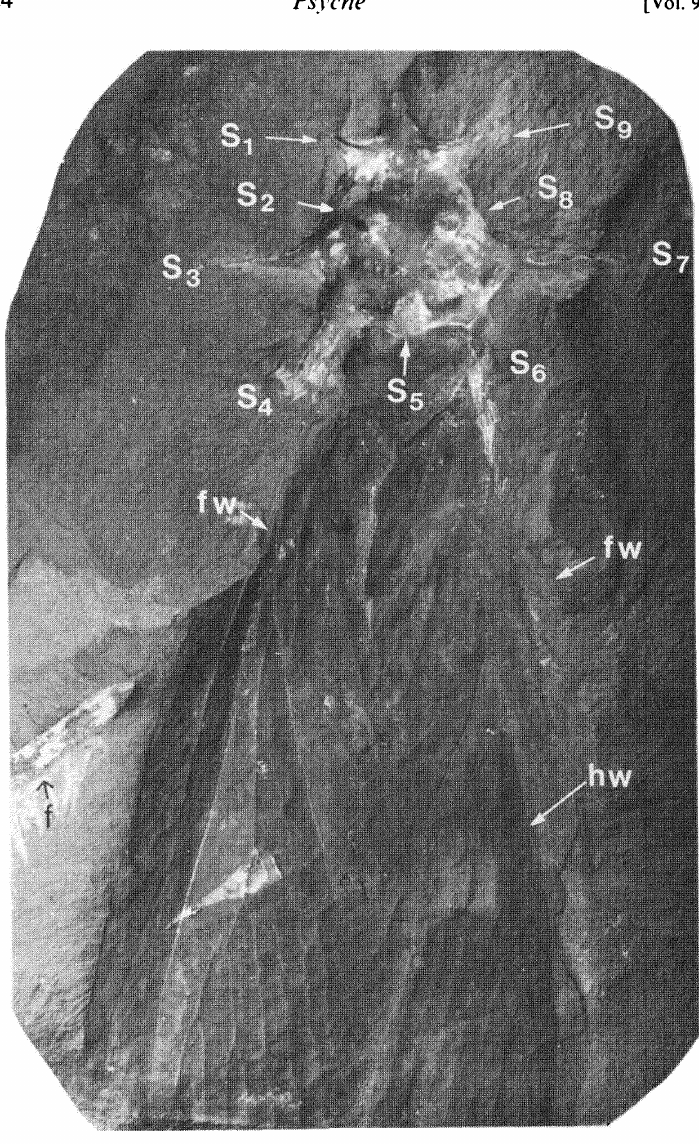
Fig. 10. Gerarus danielsi, photograph of FMNH PE 5276, obverse half. Length of fore wing 50 mm, as preserved, spine; fw fore wing; hw hind